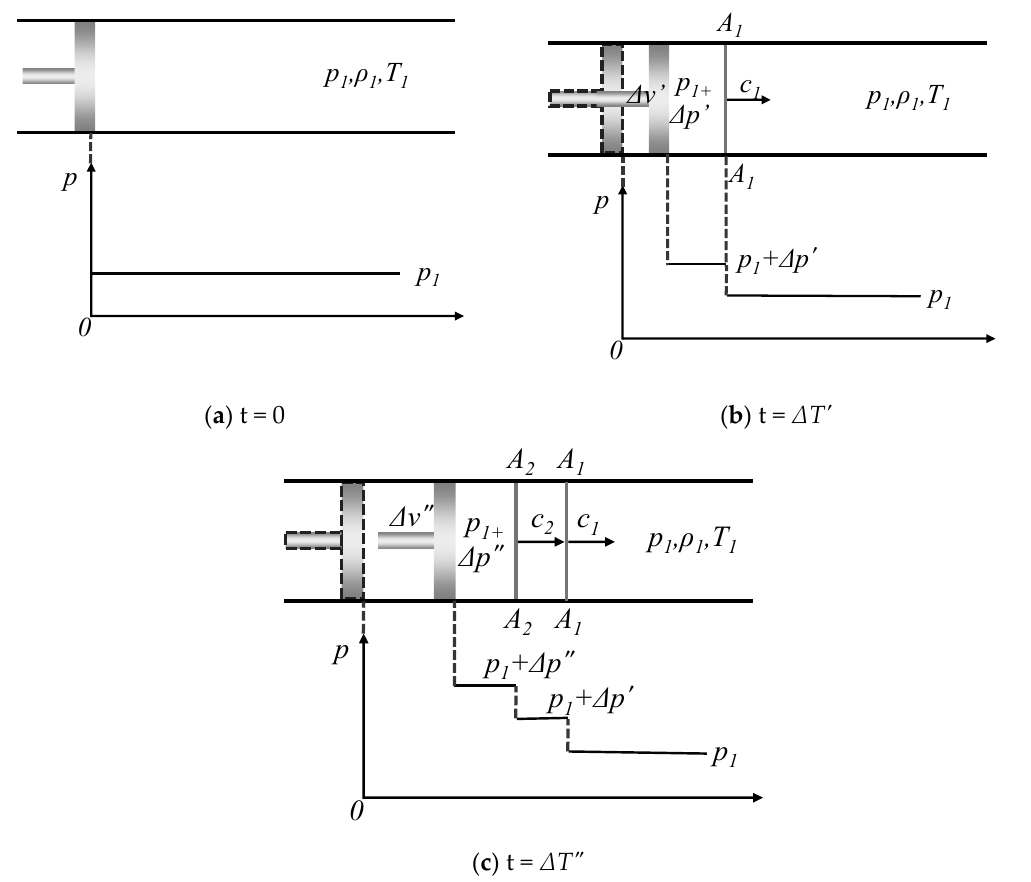
Figure 1. Schematic diagram of shock wave formation.